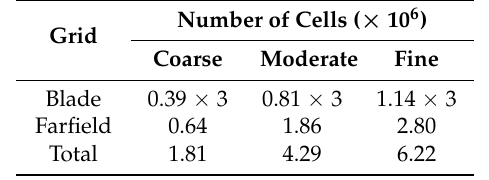
Table 3. Details of the three meshes for independence examination.